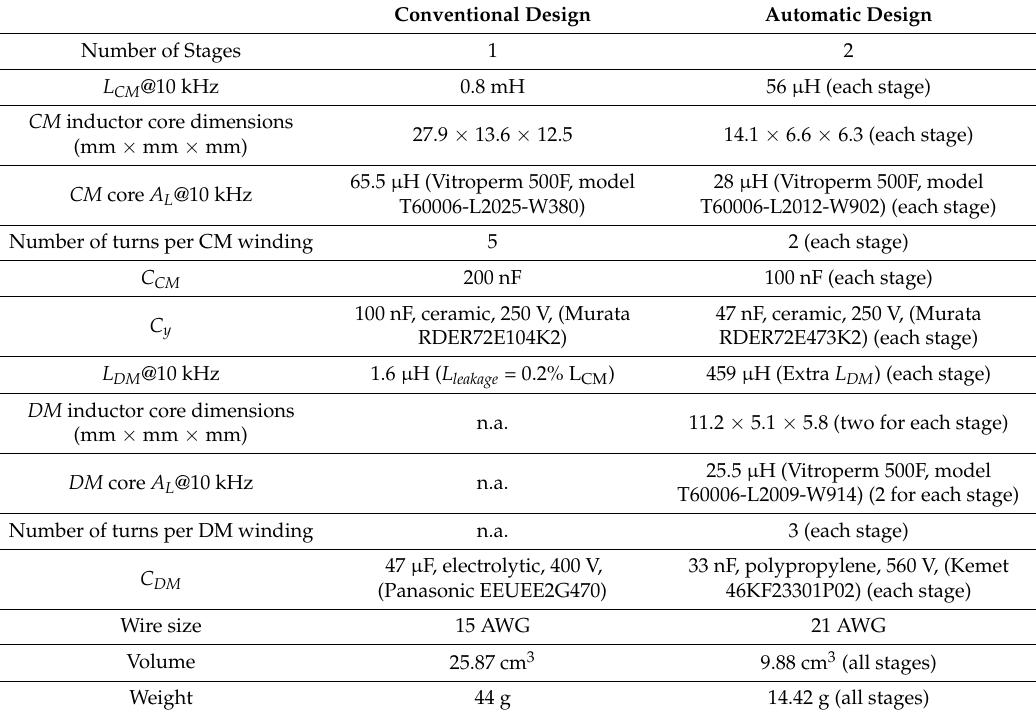
Table 4. Filter design output data–case study